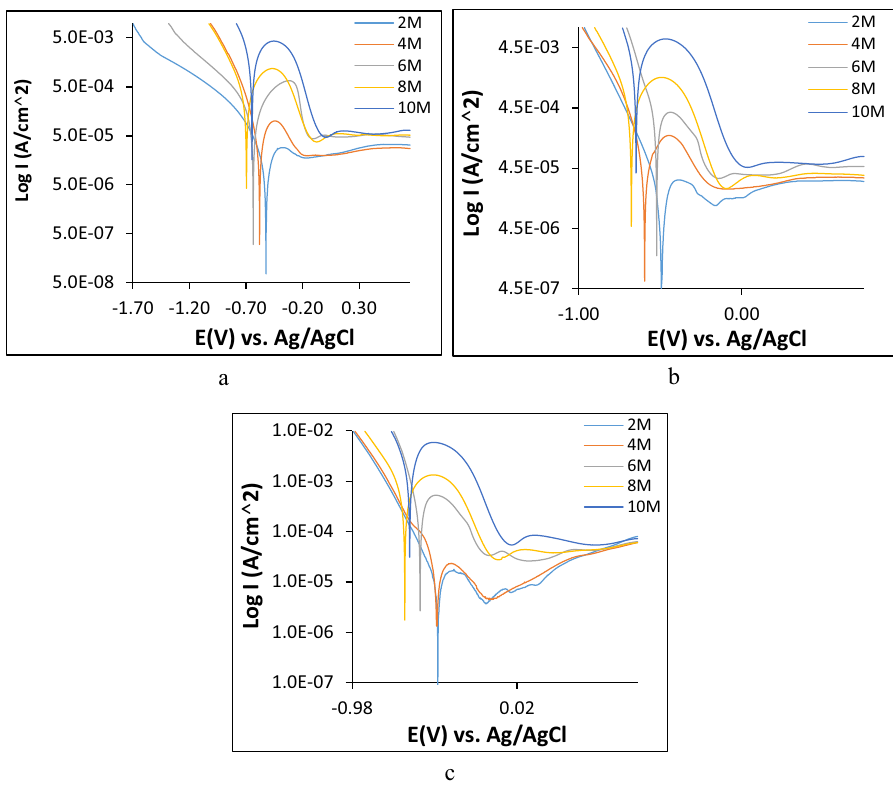
Figure 1: Potentiodynamic plots of ( a ) B265TiN, ( b ) B265TiQ, and B265TiA alloys in 2 – 10 M H 2 SO 4 solution at 10% NaCl concentration.